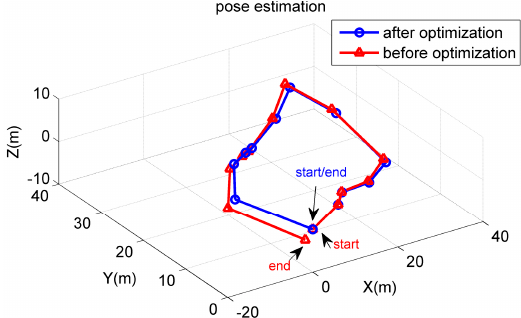
Figure 8. Pose estimation for the unmanned helicopter during one typical fly-hover-scan (the helicopter took off and landed at the same point).